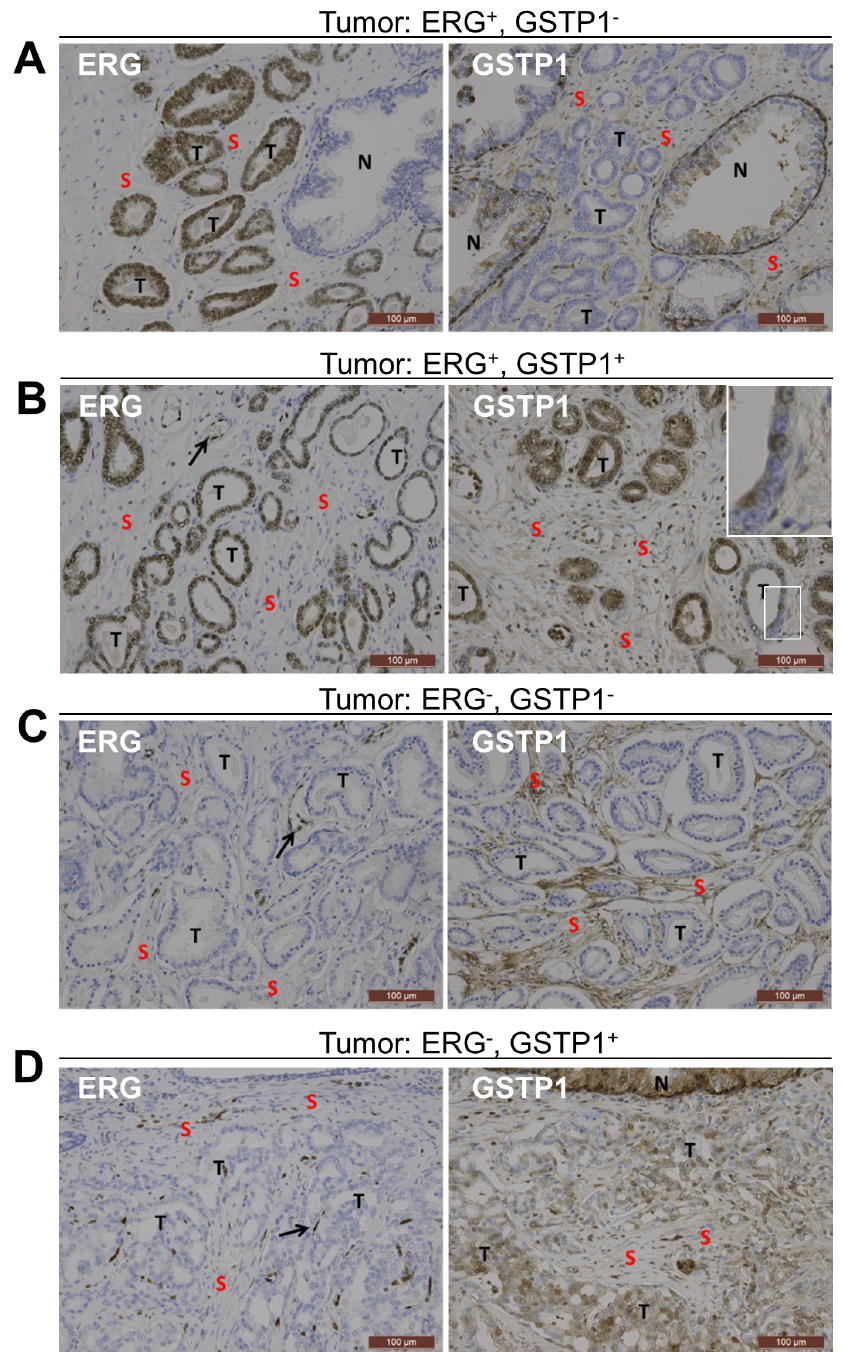
Fig 5. ERG and GSTP1 immunostainings of PCa samples from cohort PCa2. Representative immunohistochemical images of PCa samples are shown that were positive for ERG and negative for GSTP1 (A), positive for both ERG and GSTP1 (B), negative for both ERG and GSTP1(C), and negative for ERG and positive for GSTP1 (D). The internal staining control for ERG is the endothelium (arrows) and for GSTP1 the stromal and/or basal cells of normal prostate glands. N, normal prostate gland; S, Stroma; T, tumor gland. Scale bars equal 100 μ m.